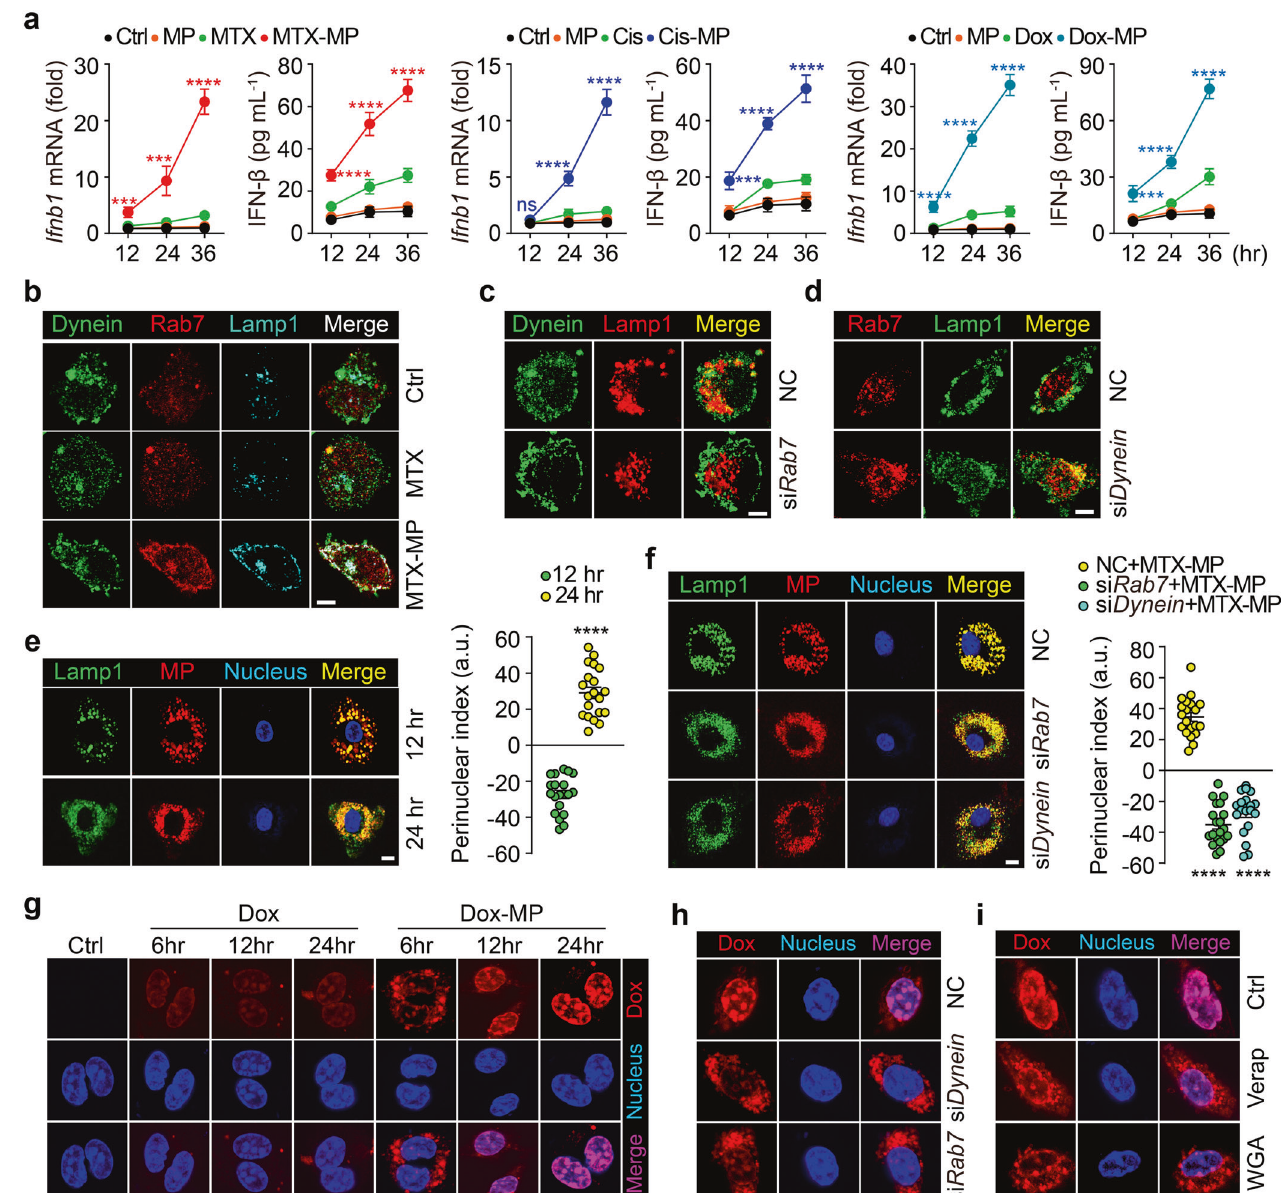
Fig. 5 Increased lysosomal pH facilitates transfer of lysosomal drugs to the nucleus. a IL-4 conditioned BMDMs were treated with T-MPs, MTX/ Cis/Dox or MTX-MPs/Cis-MPs/Dox-MPs for a different time, and IFN- β expression was analyzed by real-time PCR and ELISA. b IL-4 conditioned BMDMs were treated with MTX or MTX-MPs for 24 h and stained with anti-dynein (green), anti-Rab7 (red) and anti-Lamp1 (cyan) antibodies. c , d BMDMs were transfected with Rab7 or Dynein siRNAs for 12 h and stimulated with IL-4 for 12 h, treated with MTX-MPs for 24 h, and stained with anti-Dynein (green) and anti-Lamp1 (red) antibodies or anti-Rab7 (red) and anti-Lamp1 (green) antibodies. e IL-4 conditioned BMDMs were treated with PKH26-labeled MTX-MPs for 12 or 24 h and stained with anti-Lamp1 (green) antibodies. DAPI was used to stain the cell nuclei (blue). The intracellular distribution of the lysosome was observed and quanti fi ed as described in the methods. f BMDMs were transfected with Rab7 or Dynein siRNAs for 12 h and stimulated with IL-4 for 12 h, treated with PKH26-labeled MTX-MPs for 24 h and stained with anti-Lamp1 (green) antibodies. g IL-4 conditioned BMDMs were treated with Dox or Dox-MPs for a different time and stained with DAPI. h BMDMs were transfected with Rab7 or Dynein siRNAs for 12 h and stimulated with IL-4 for 12 h, then treated with Dox-MPs for 24 h, and stained with DAPI. i IL-4 conditioned BMDMs were pretreated with Verapamil (1 mM) or WGA (75 μ g mL -1 ) for 4 h and treated with Dox-MPs for 24 h, and stained with DAPI. For b – i , cells were observed under a two-photon confocal microscopy. Scale bars, 5 μ m. Unless otherwise speci fi ed, n = 3 biologically independent experiments were performed. Data are presented as mean ± SEM. P values were calculated using one-way ANOVA (a and f) and two-tailed unpaired Student ’ s t -tests (e). *** P < 0.001, **** P < 0.0001 lysosomal pH of macrophages, as shown in Fig. 2e, f. Although the other hand, lysosomal vacuolar-type H + -ATPase (V-ATPase), mechanism underlying MP-mediated decrease of lysosomal pH composing of V0 and V1 domains, continually pumps protons has not been fully elucidated, the oxidized cholesterol in tumor from the cytosol into the lysosomal lumen in order to replenish cell-derived MPs might be involved in the mechanism. Such the proton loss. 7 Of note, MPs and MTX-MPs may have different oxidization is mediated by the cholesterol 25-hydroxylase, which effects on lysosomal pH. MPs decrease but drug-MPs increase the Signal Transduction and Targeted Therapy (2023)